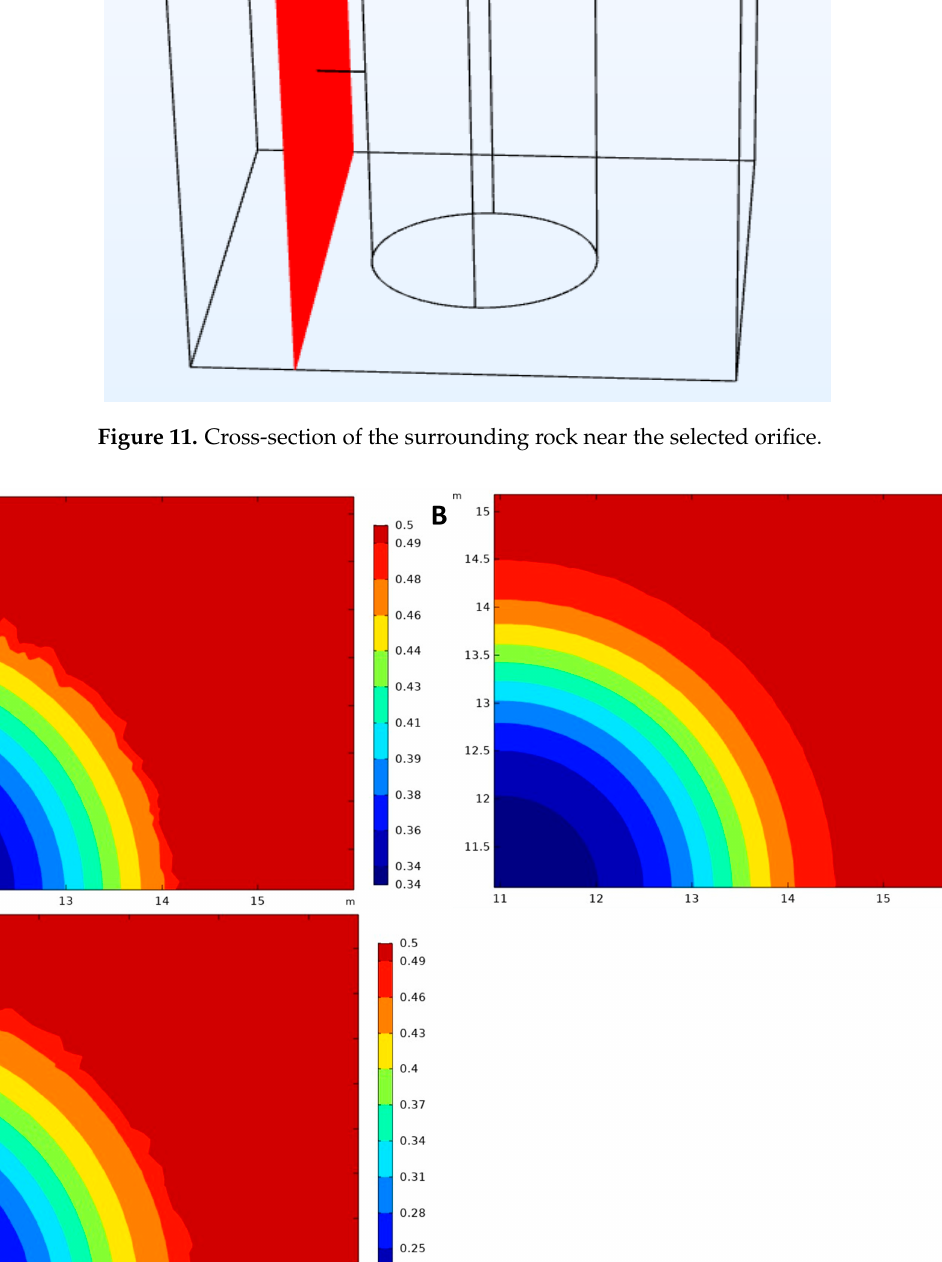
Figure 12. Variation in porosity of surrounding rock with time t: ( A ) 50 min, ( B ) 60 min, ( C ) 70 min. The findings indicated that the porosity ϕ of the surrounding rock behind the wall was slightly increased with increase in diffusion radius r as the slurry diffused (Figure